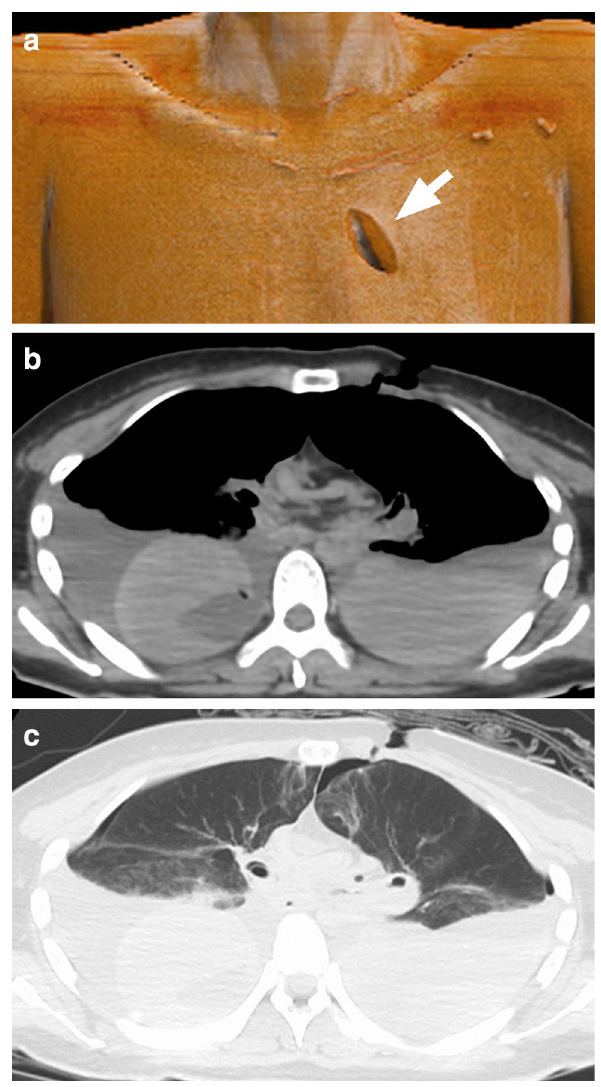
Figure 6. A 49-year-old woman killed with a knife. (( a ) 3D CT GIR image, ( b ) axial CT image (soft kernel), ( c ) axial CT image (lung kernel)). ( a ) 3D CT GIR image showing a stab wound at the left anterior thorax (arrow). ( b,c ) The axial CT images show bilateral hemopneumothorax suggesting that the knife stabbed into the left anterior thorax penetrated the mediastinum and reached the right